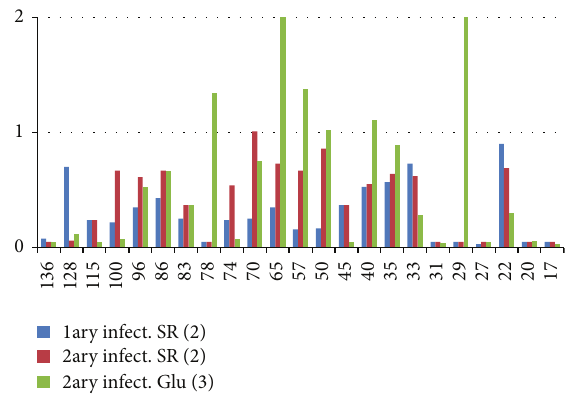
Figure 4: IOD area values in spontaneous remission (SR) after pri- mary infection (infect.) SR and post-Glu treatment after secondary infection (patients). Standard deviations were 5–20% of average and are not shown for the sake of